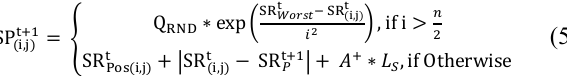
Algorithm 1: The primitive steps of the